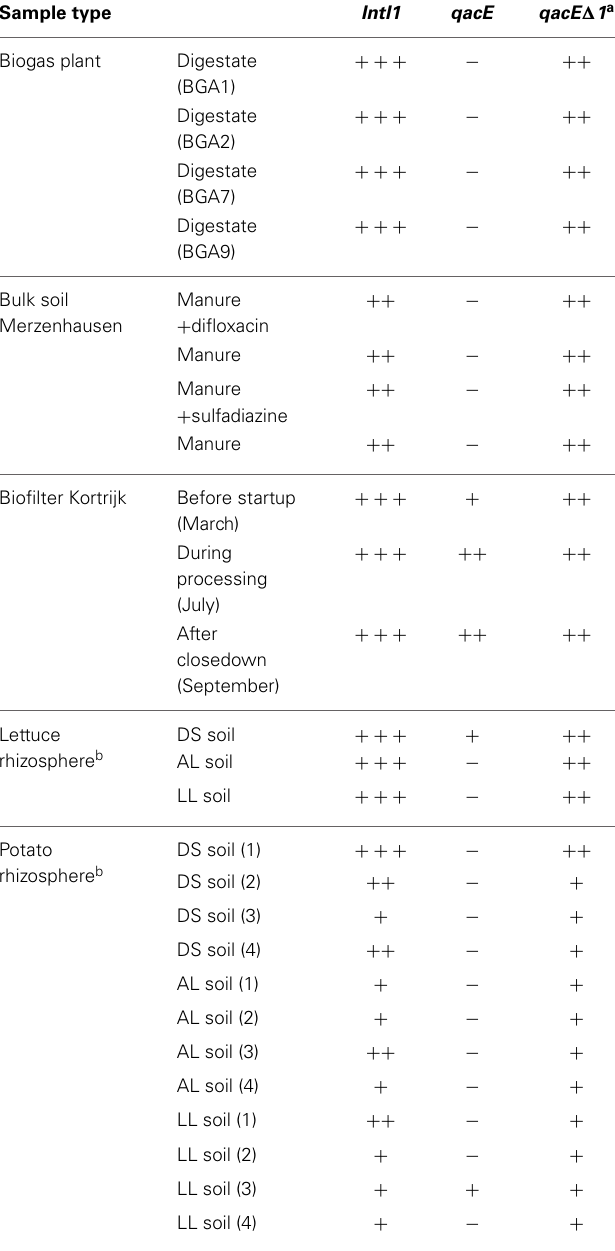
Table 1 | Detection of class 1 integron integrase genes ( intI1 ) and quaternary ammonium compound resistance genes qacE and qacE (cid:2) 1 by PCR and subsequent Southern blot